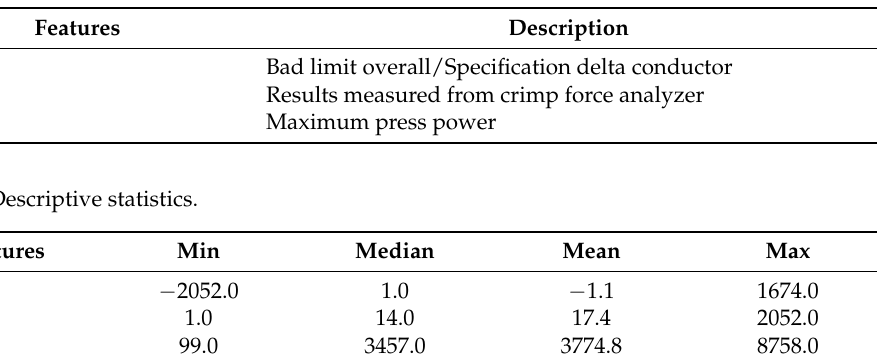
Table 5. Description of features.